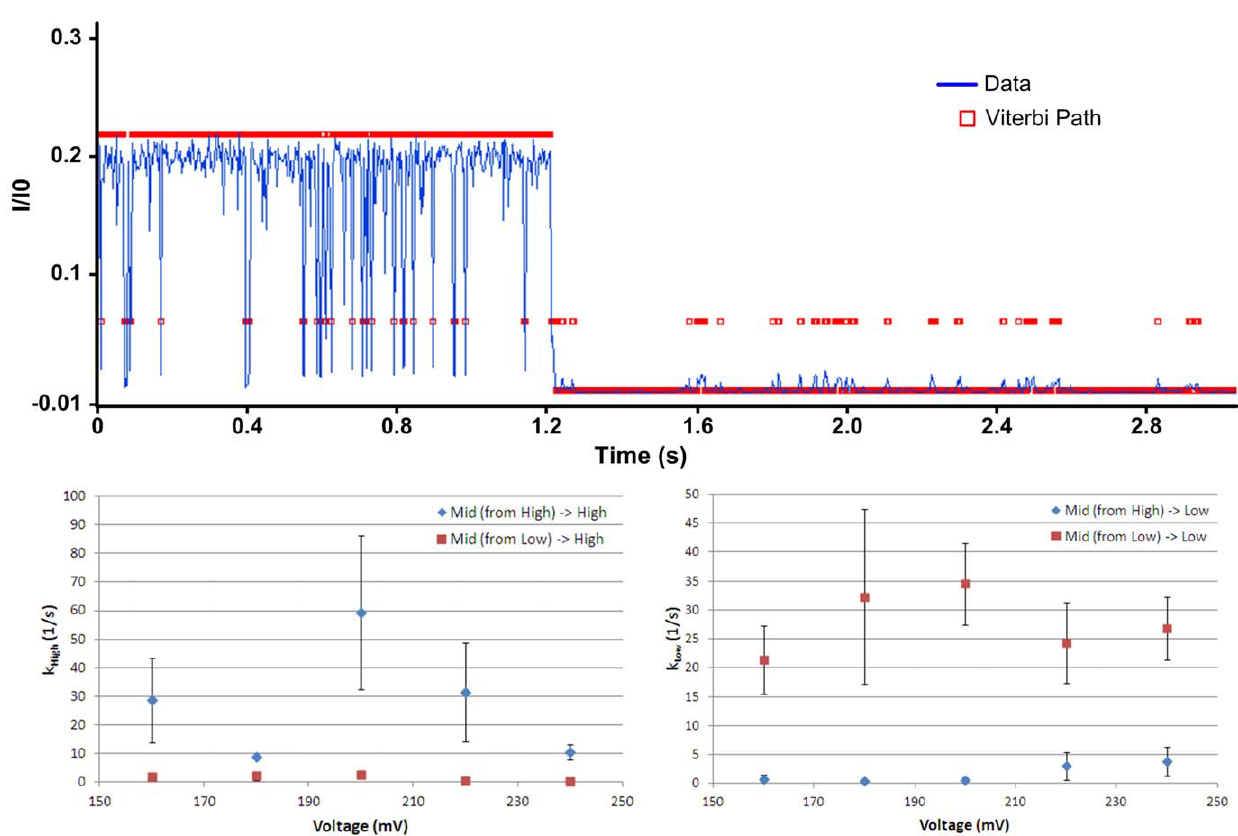
Figure 6. KKRR-ShPrP(120–232) mid-state statistics as a function of voltage. (Top) A sample KKRR-ShPrP(120–232) event (blue) with the most likely state sequence (i.e. Viterbi path) overlayed (red) as determined by a Viterbi analysis of the event. The sample event highlights the dependence of mid-state statistics (i.e. the transition rates out of the mid-state) on how the mid-state is entered. The event qualitatively shows that if the mid-state is entered from the high state then a transition back to the high-state is more likely than a transition into the low-state. Likewise, transitions into the mid-state from the low-state are more likely to return to the low-state as opposed to entering the high-state. (Bottom left) Mid- state transition rate into the high-state as a function of voltage, depending on how the mid-state is entered. If the mid-state is entered from the high- state (blue) the transition rate back into the high-state is between one and two orders of magnitude higher (depending on voltage) than the transition rate into the high-state when the mid-state is entered from the low-state (red). (Bottom right) Mid-state transition rate into the low-state as a function of voltage, depending on how the mid-state is entered. If the mid-state is entered from the low-state (red) the transition rate back into the low-state is between one and two orders of magnitude higher (depending on voltage) than the transition rate into the low-state when the mid- state is entered from the high-state (blue). doi:10.1371/journal.pone.0054982.g006 mutant PrP C are easily distinguished based on their kinetics in the pore. The results substantially improve, particularly in the case of wild-type predictive value, when only long-time events are considered. These results demonstrate that nanopore analysis in combination with HMM signal processing can be used to detect